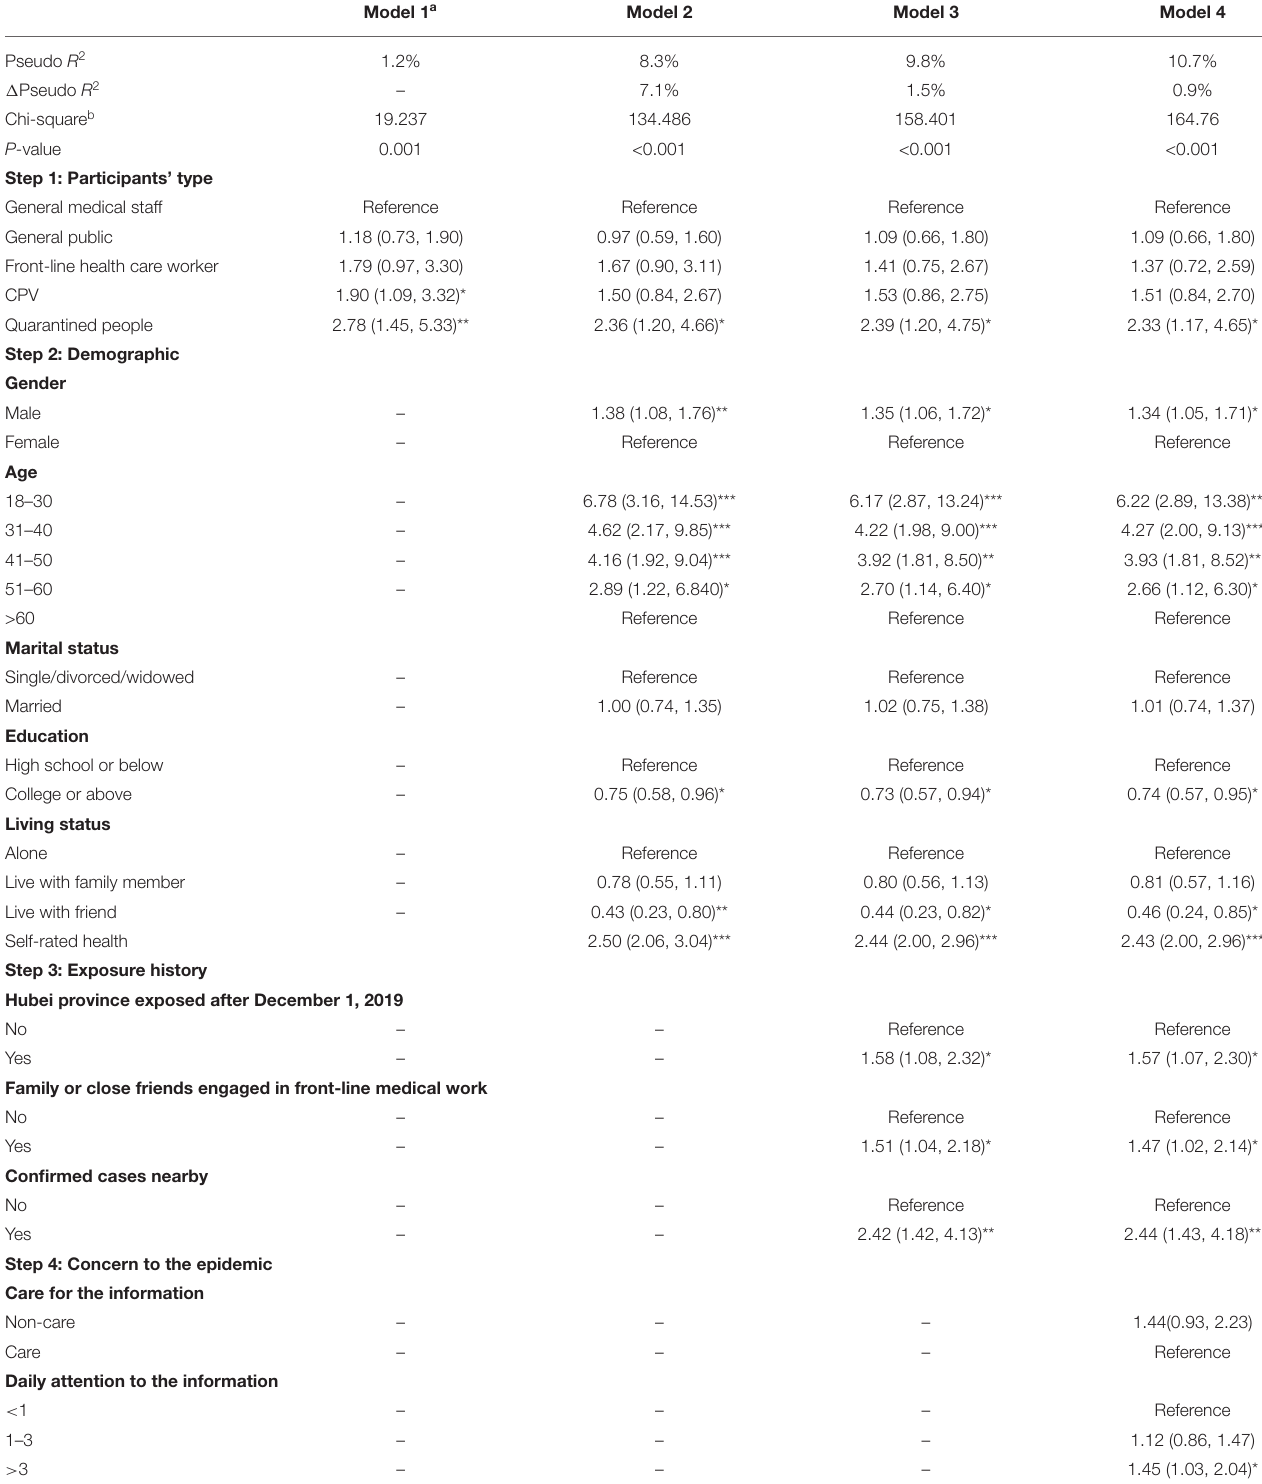
TABLE 2 | Multiple logistic regression analysis of factors associated with